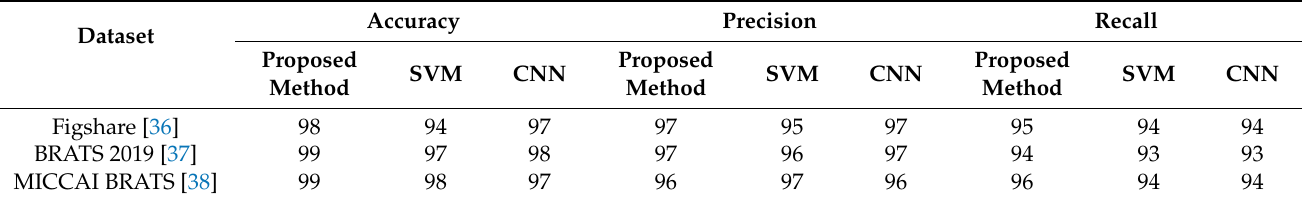
opo P r Figure 12. Comparison of performance metrics with currently used methods.